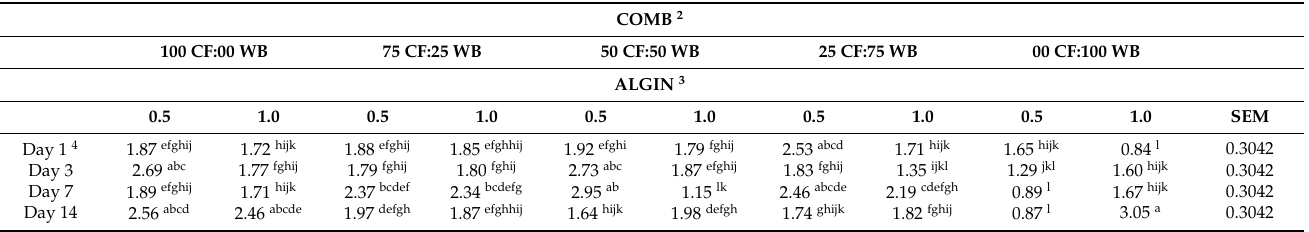
Table 5. Interactive effect of COMB × ALGIN × DAY on TBARS 1 value of pet food formulations during a simulated retail display. COMB 2